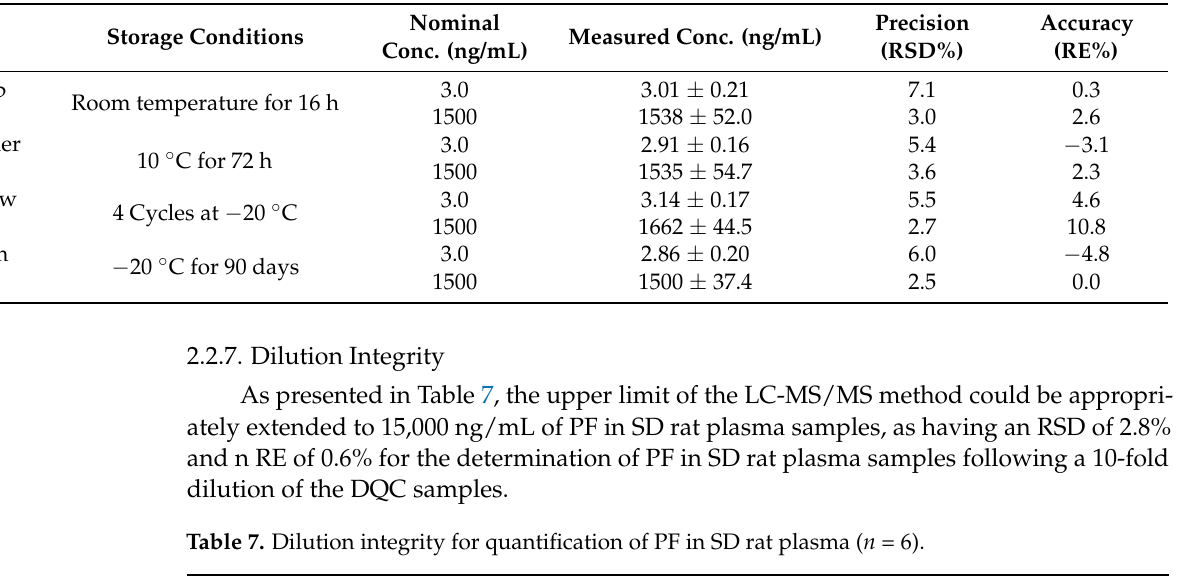
Table 6. Stability of PF in SD rat plasma under diverse storage conditions ( n = 6).